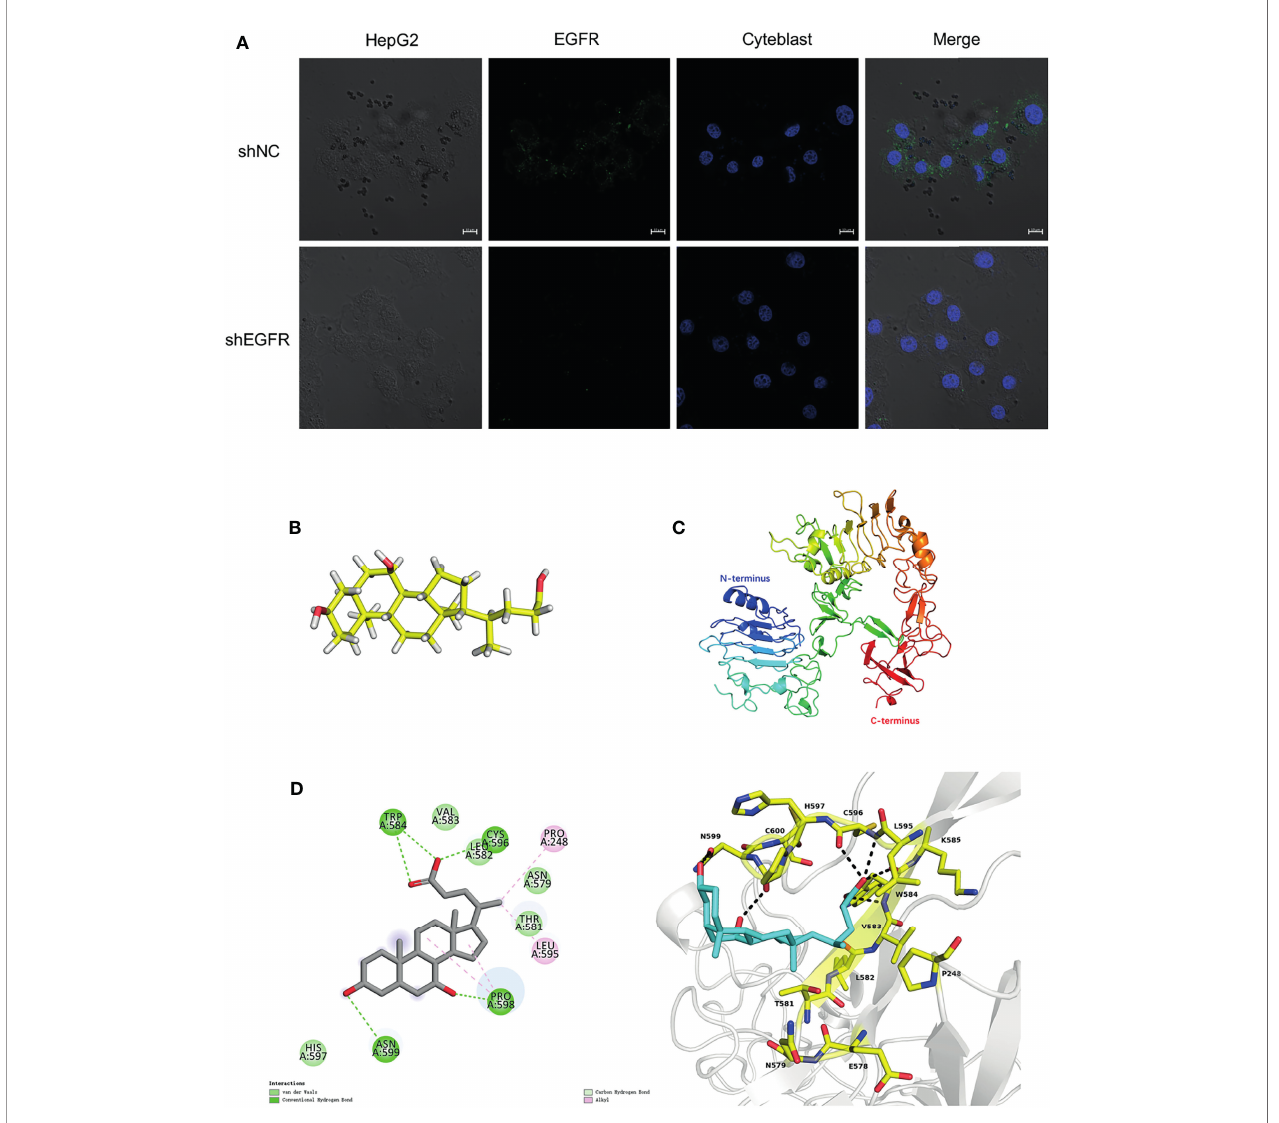
FIGURE 8 | CDCA binds to EGFR extracellular structural domain. (A) Immuno fl uorescence confocal microscopy showing magnetic beads-CDCA aggregating around HepG2 cells (60x). (B) CDCA molecular structures. (C) EGFR protein 3D structures (ID:4UV7). (D) CDCA binds to the extracellular structural domain of